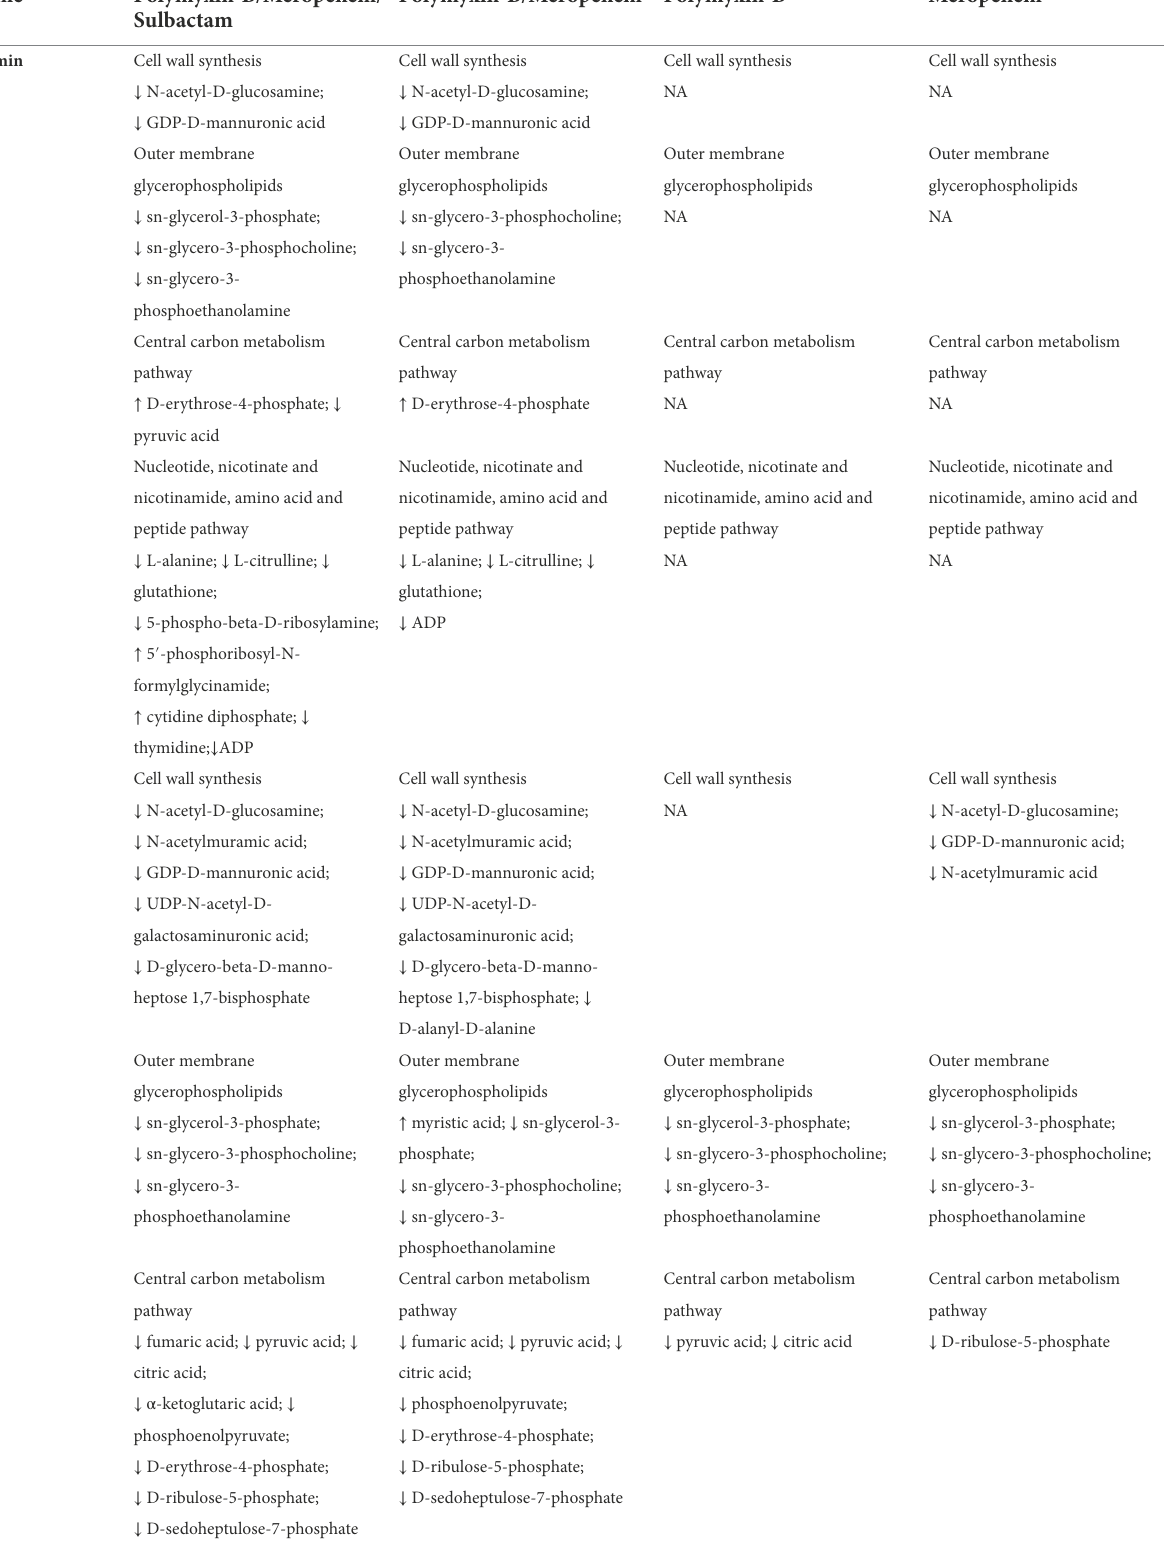
TABLE 3 Sequence of metabolomic changes in Acinetobacter baumannii after polymyxin-B and meropenem treatments as monotherapy and in combination with and without sulbactam. Time Polymyxin-B/Meropenem/ Polymyxin-B/Meropenem Polymyxin-B Meropenem Sulbactam 15 min Cell wall